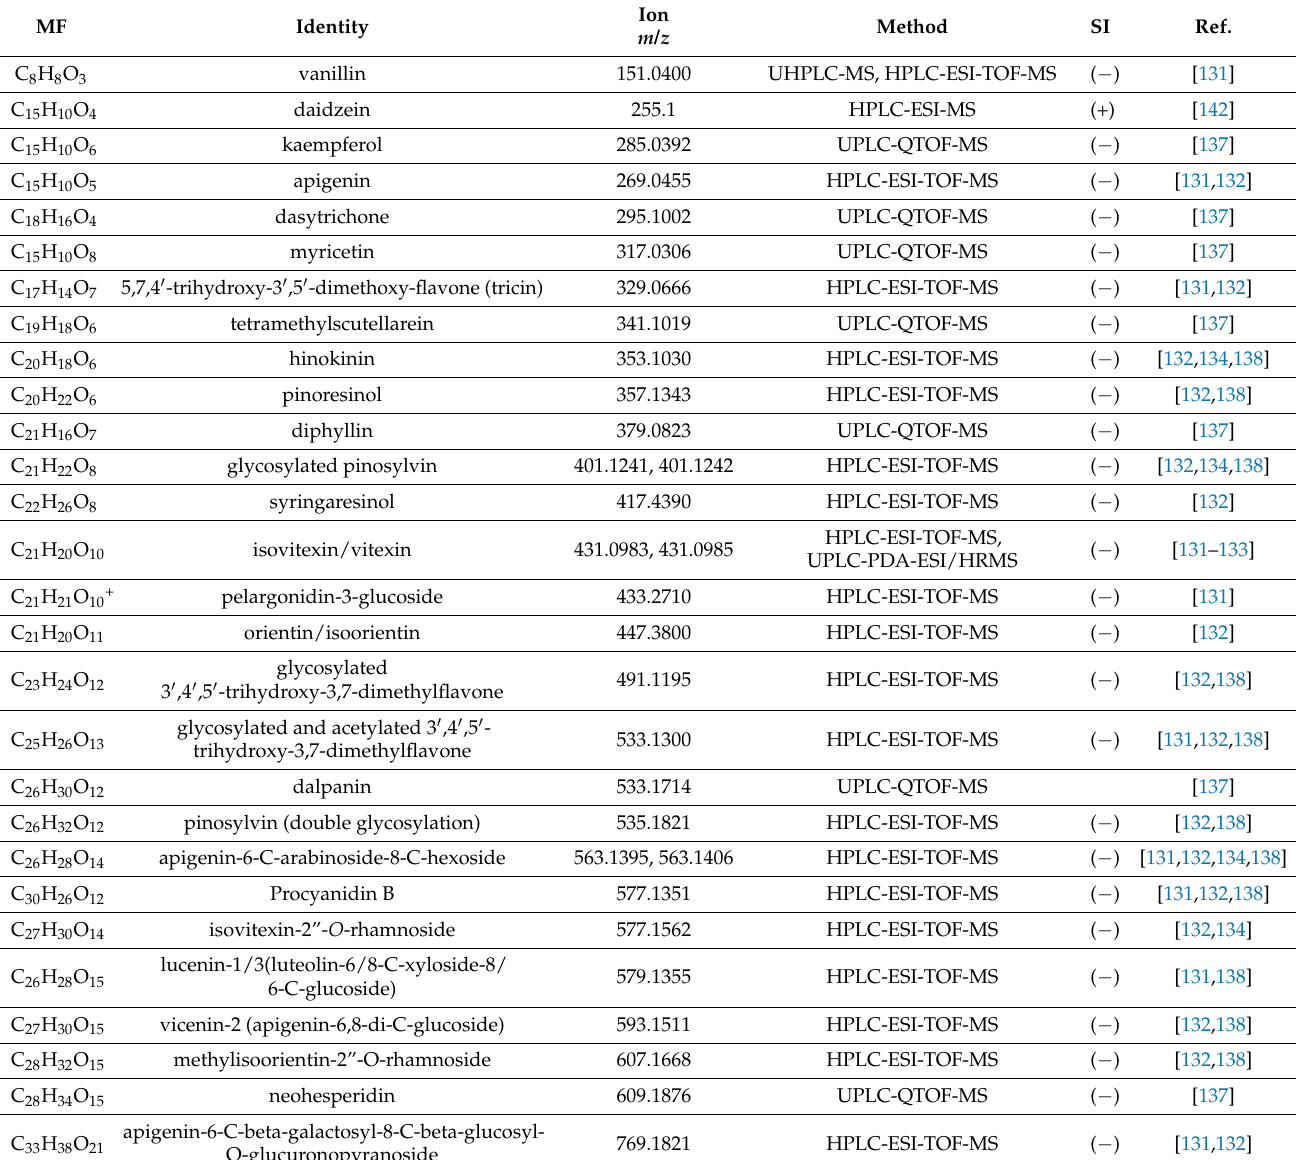
Table 4. Aldehydes, coumarins, stilbenoids, monomeric flavonoids, proanthocyanidins, and lignans in wheat using HPLC and MS-based